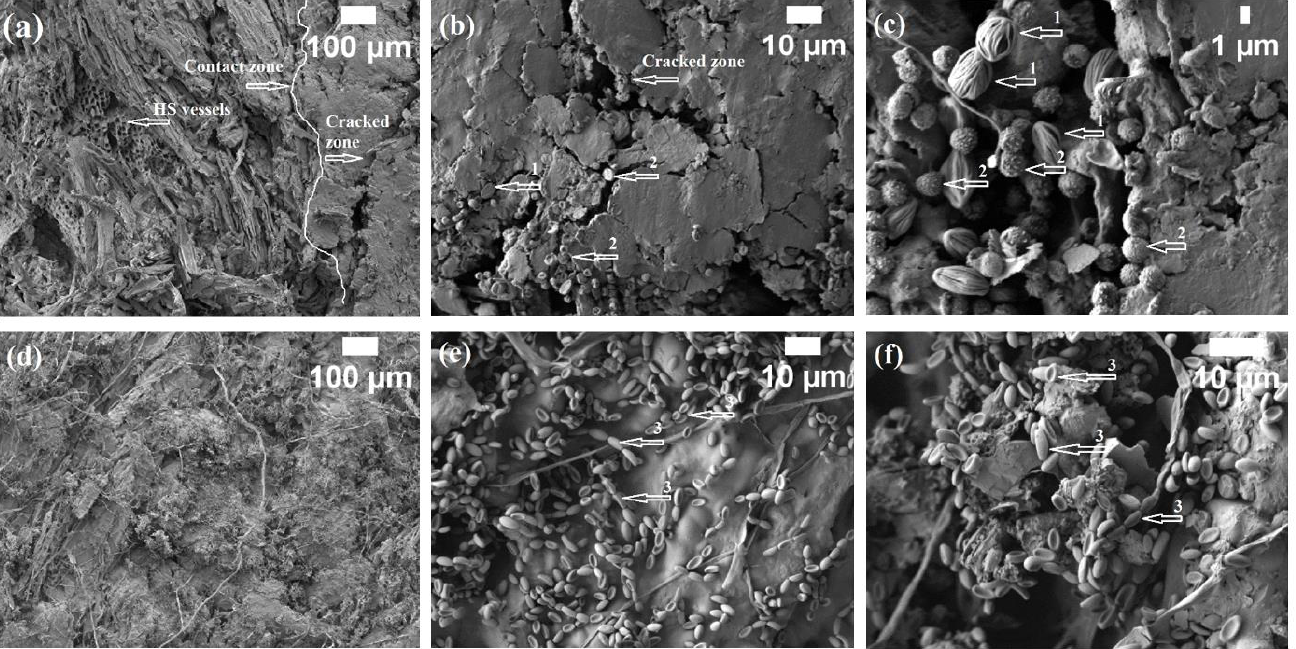
Figure 5. Microstructure of HS- and CS-based biocomposites impregnated with different oils after incubation for 6 months (1 — fungus Rh. oryzae , 2 — fungus A. fumigatus , 3 — bacterium P. putida ): ( a